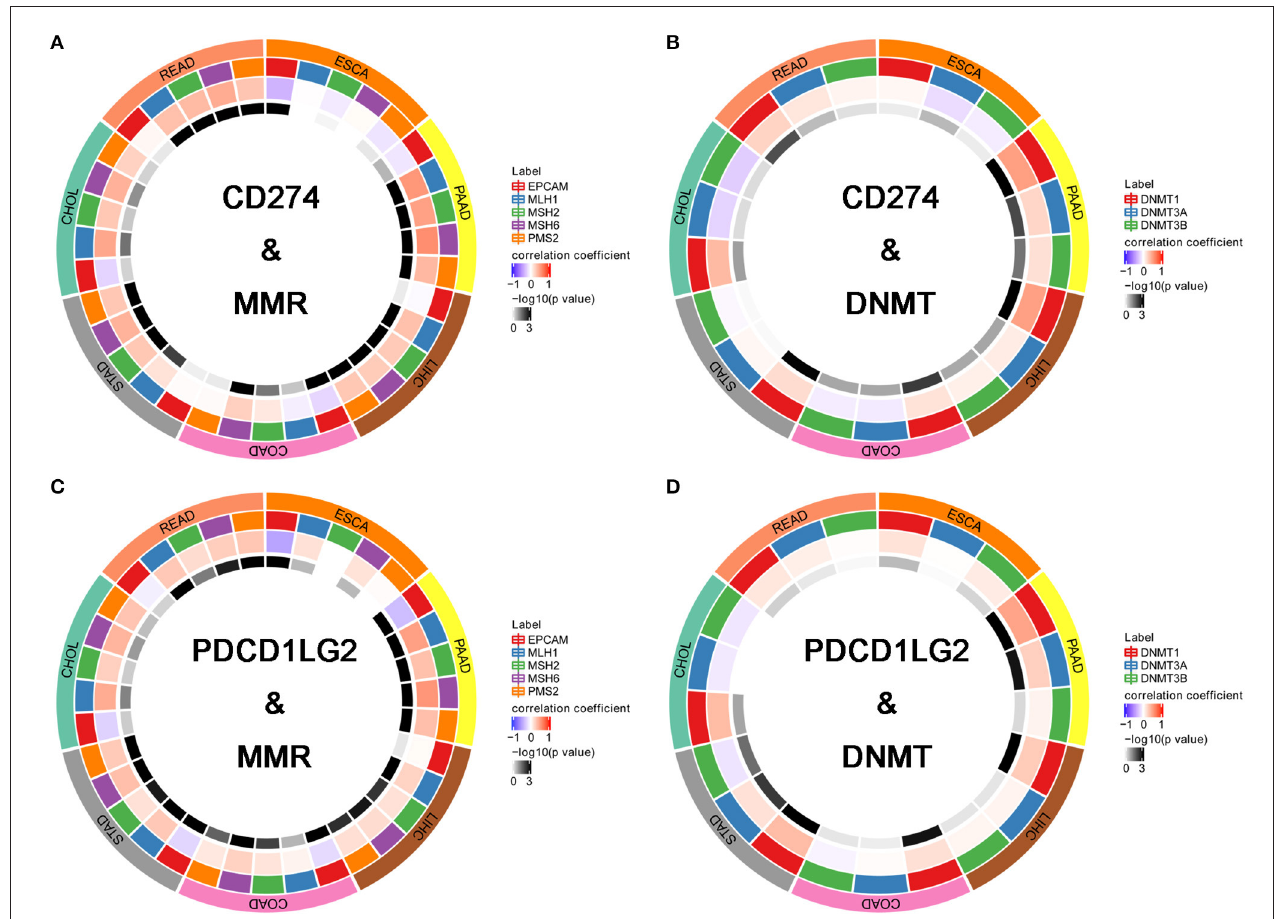
FIGURE 6 | CD274/PDCD1LG2 expression is correlated with mismatch repair (MMR) and DNA methyltransferase (DNMT). (A) Circle chart displaying the overlap between CD274 and MMR across seven cancers. The first outer ring representing cancer types; the second outer ring representing five MMR genes; the third outer ring representing a correlation coefficient; and the fourth outer ring is colored representing a p -value. (B) CD274 and DNMTs. (C) PDCD1LG2 and MMRs. (D) PDCD1LG2 and